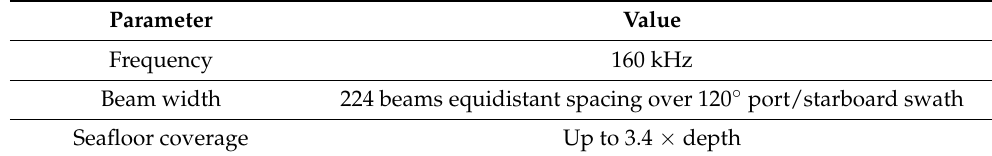
Figure 2. Components of the multibeam echo sounder WASSP WMB-3250: BTxR transceiver ( a ), WASSP processor ( b ), transducer ( c ). Table 1. Main technical characteristics of the WASSP WMB-3250 multibeam